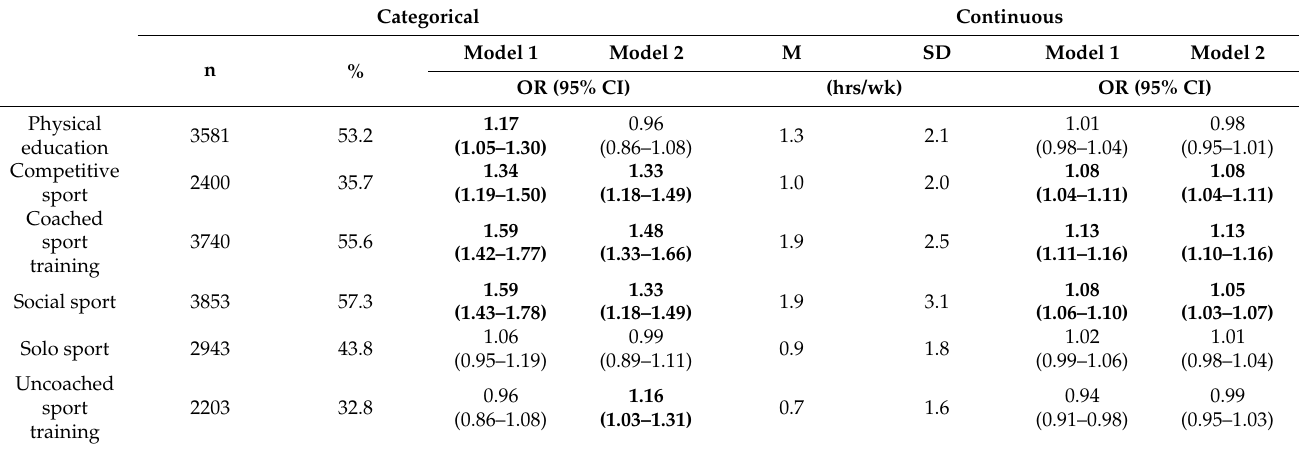
Table 1. Association between participation in the various sports settings and wellbeing (n = 6725).